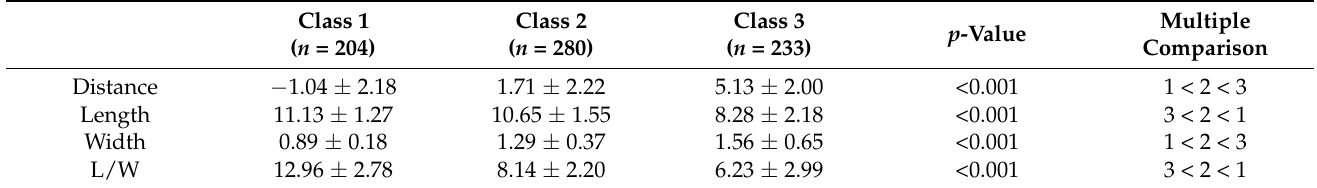
Table 3. Differences in disc quantitative measurements among the three-disc morphology categories.